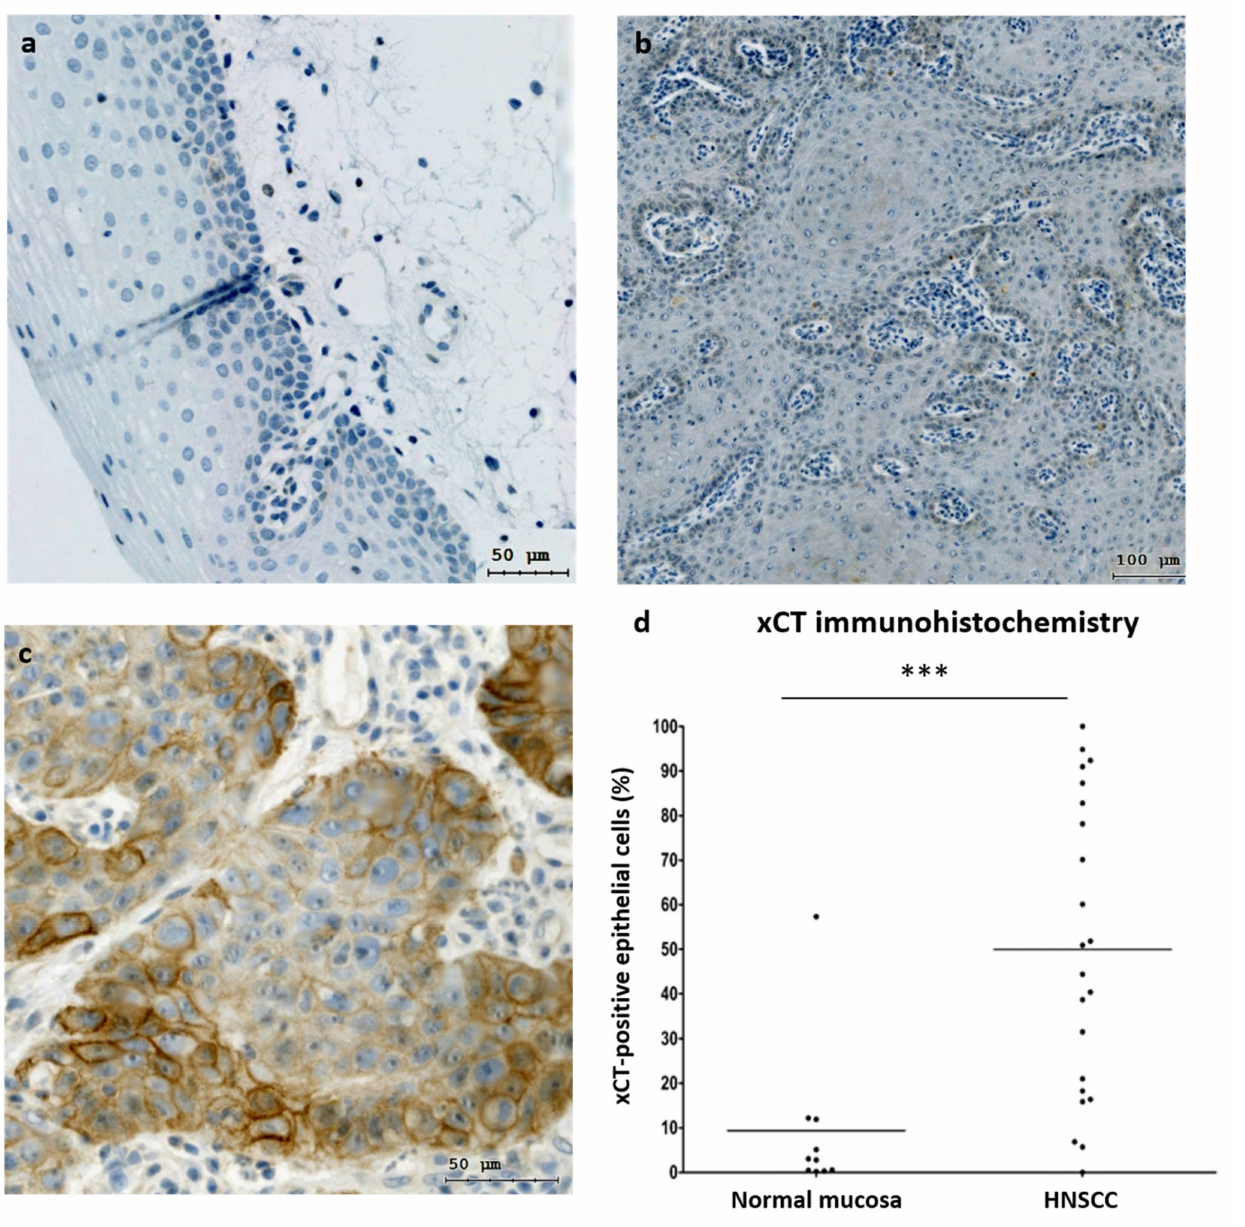
Figure 2. xCT (SLC7A11) expression in normal mucosa and HNSCC samples. Immunohistochemical representation of xCT obtained via TissueFax®(TissueGnostocs™, Vienna, Austria) in normal mucosa ( a ) and tumor tissue ( b , c ); 400 × magnification, bar: 50 µ m ( a , c ); 200 × magnification, bar: 100 µ m ( b ). Differences in xCT expression in normal mucosa and HNSCC samples ( d ). Statistical analysis was performed with the Mann–Whitney test, *** p <